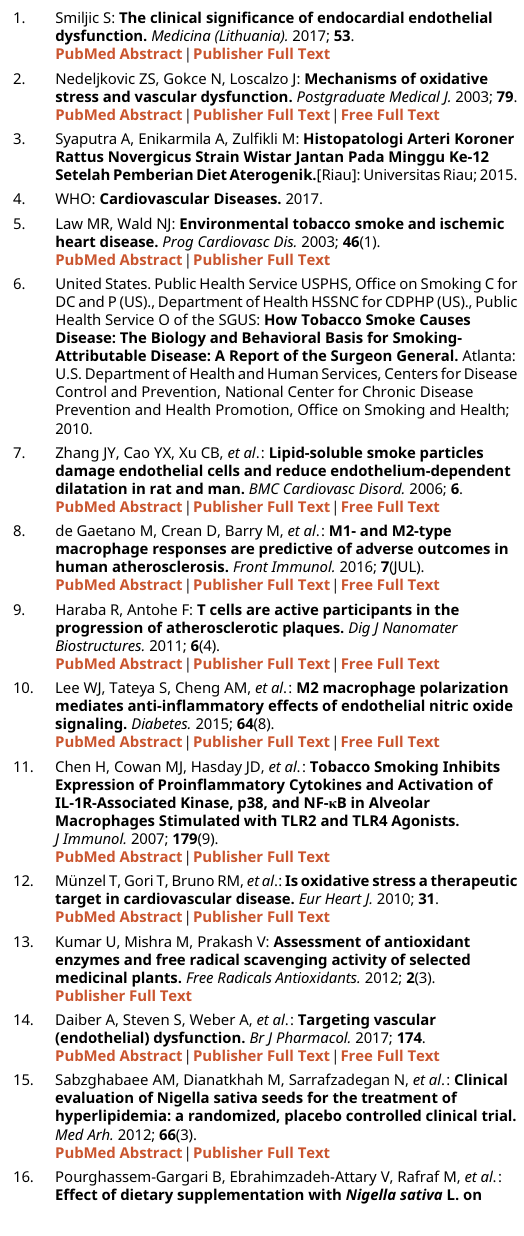
Figshare: ARRIVE checklist for ‘ Preventive effect of Nigella sativa in M1 / M2 ratio reducing risk of endothelial dysfunction in cigarette smoked Wistars ’